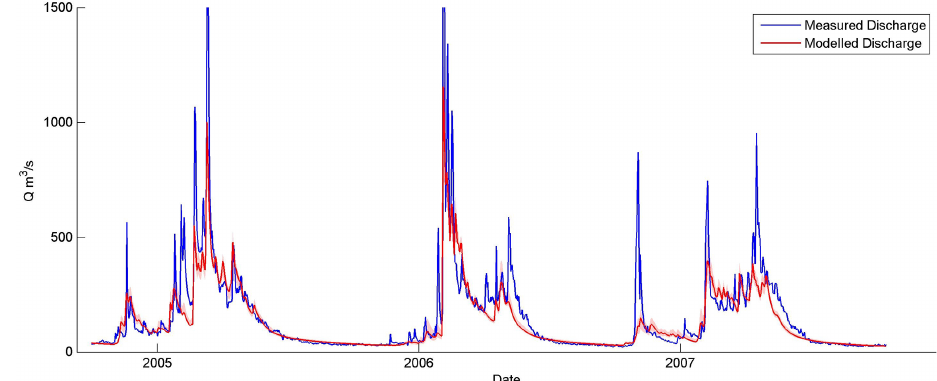
Figure 9. Discharge curves for the Dukan catchment between (October 2005 and October 2007). (left) Measured discharge in blue against modelled discharge in red. The red line gives the optimal solution and the bandwidth represents solutions within the Pareto ensemble. (right) Identical to left graph but here on a log scale, which gives a better view on the low flows during the dry season.